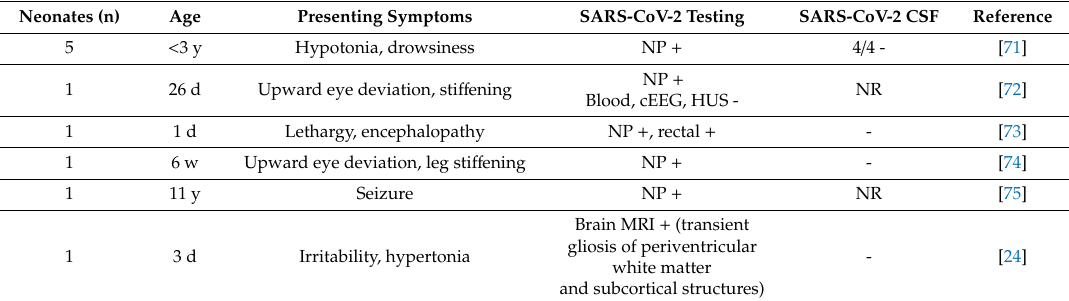
Table 3. Selected case reports of COVID-19 neurologic involvement in neonates and